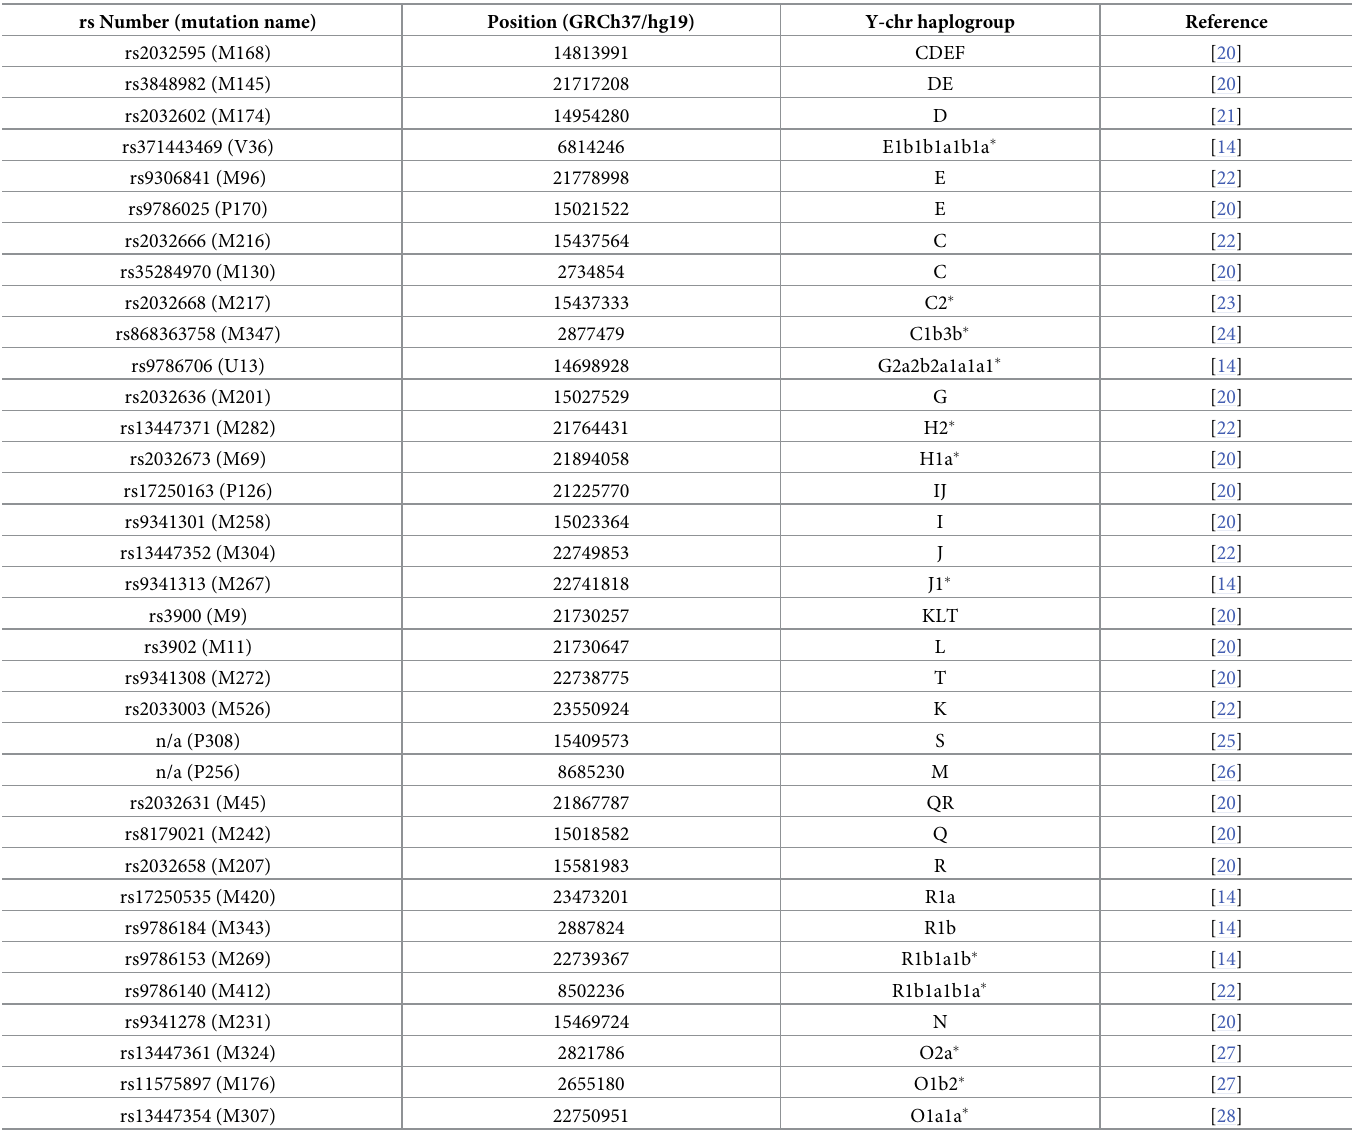
Table 3. Details of the 35 Y-chromosome SNPs included in the hybridisation enrichment